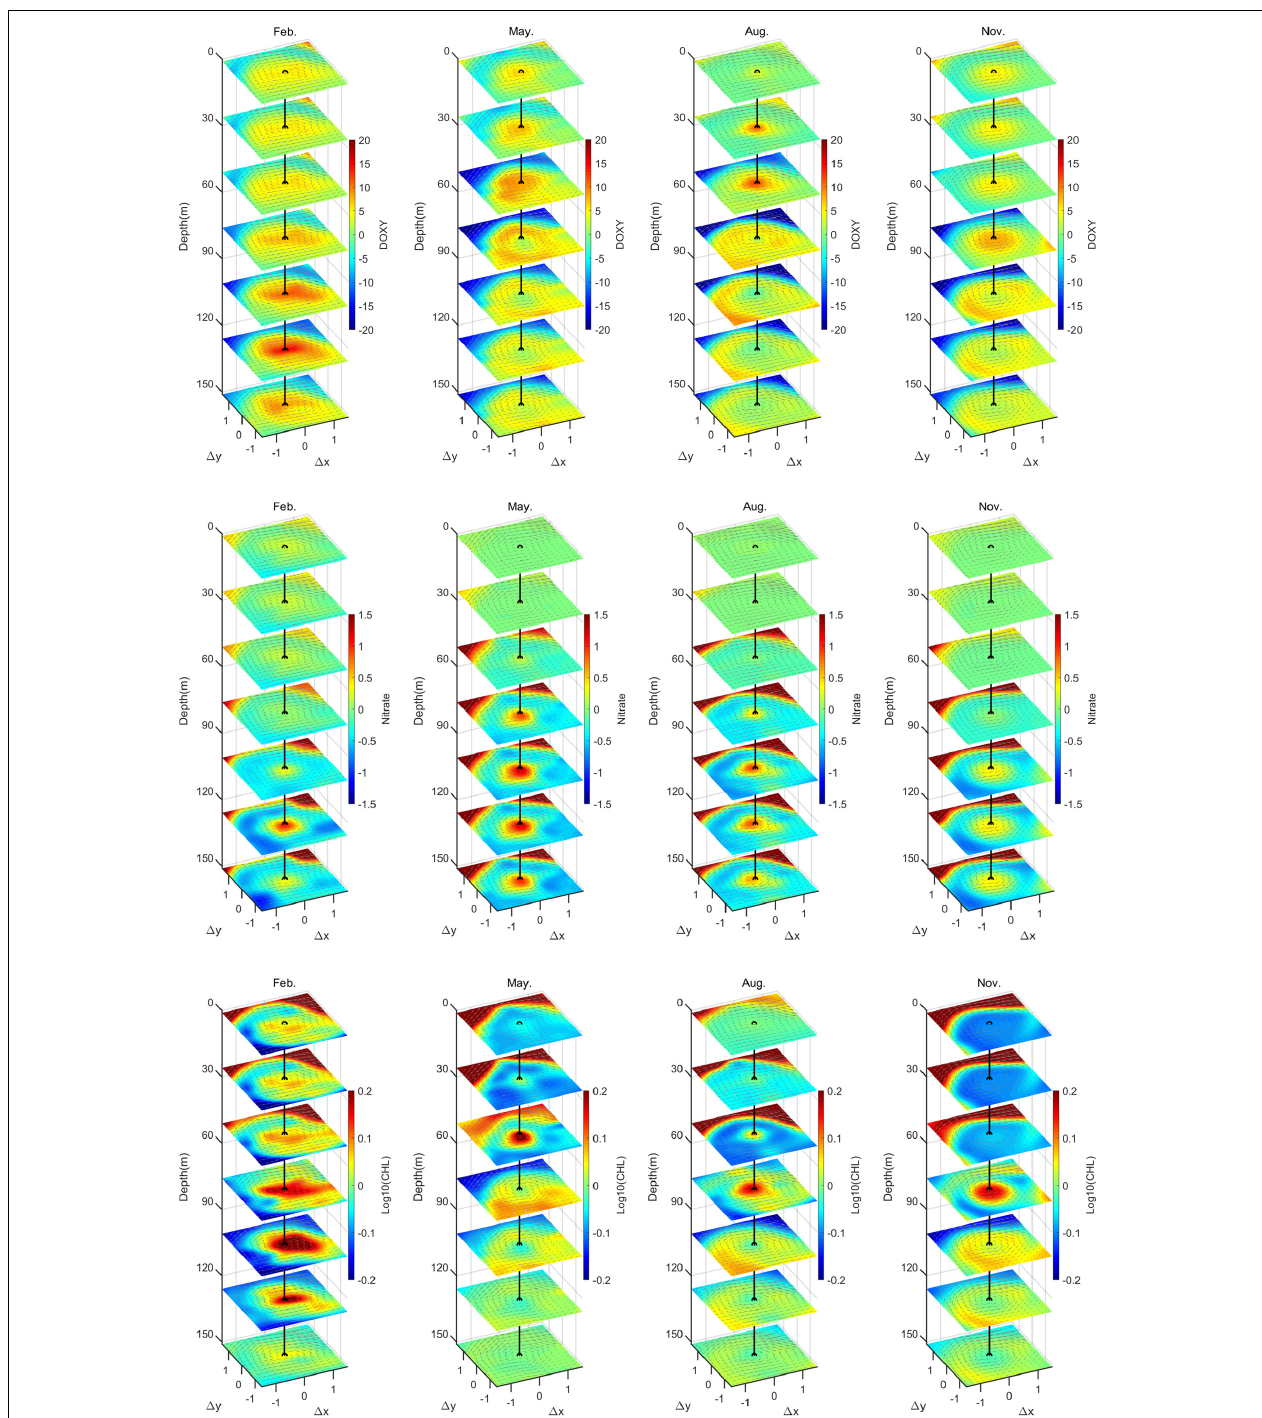
FIGURE 9 | Composite three-dimensional anomaly structures of SSAE in February, May, August and November. From the top to the bottom, the rows show the structures of CHL (mg m − 3 ), NO 3 ( µ mol kg − 1 ), and DO ( µ mol kg − 1 ).